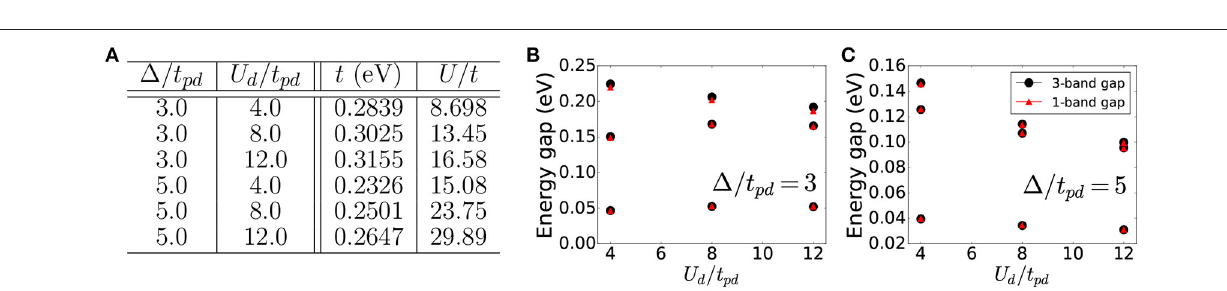
3 and various U d / t pd ; (B) 1/ t pd =